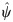
Measures of variation.(A)-(B) CV of ψ^ in % (i.e. ×100) as a function of ψ for the conditional Poisson model. The dashed line is the respective prediction based on the Cramér-Rao lower bound. Almost identical pictures are obtained for the other models (conditional Poisson, shifted Poisson, conditional binomial and shifted binomial). Panels are for different p (with different lineage numbers n). (C)-(D) CV for lineage frequencies. Shown is the theoretical prediction which is almost indistinguishable from the curves obtained by simulation, for all models. Panels are for different p (with different lineage numbers n). (E)-(F) Average Euclidian distance of the MLE p^ and the true parameter p. Shown are the curves obtained from the conditional Poisson model. Panels are for different p (with different lineage numbers n).